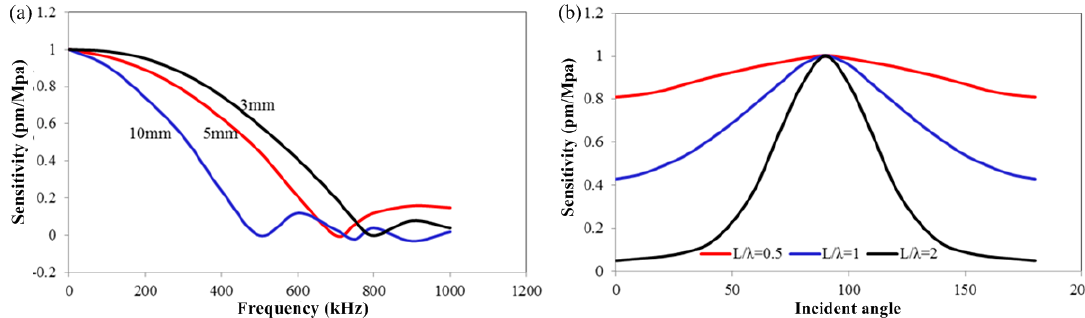
Figure 13. Simulation results: ( a ) FBG length versus response sensitivity; ( b ) Detection direction versus response sensitivity.